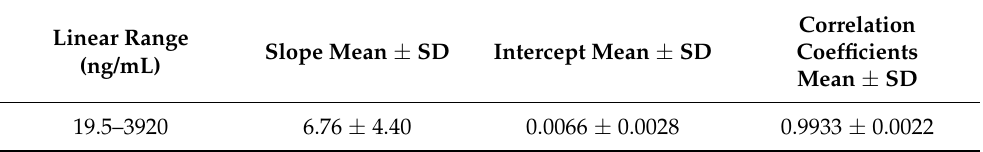
Table 3. Analytical parameters of the HPLC-FLD method used for quantification of capmatinib in rat